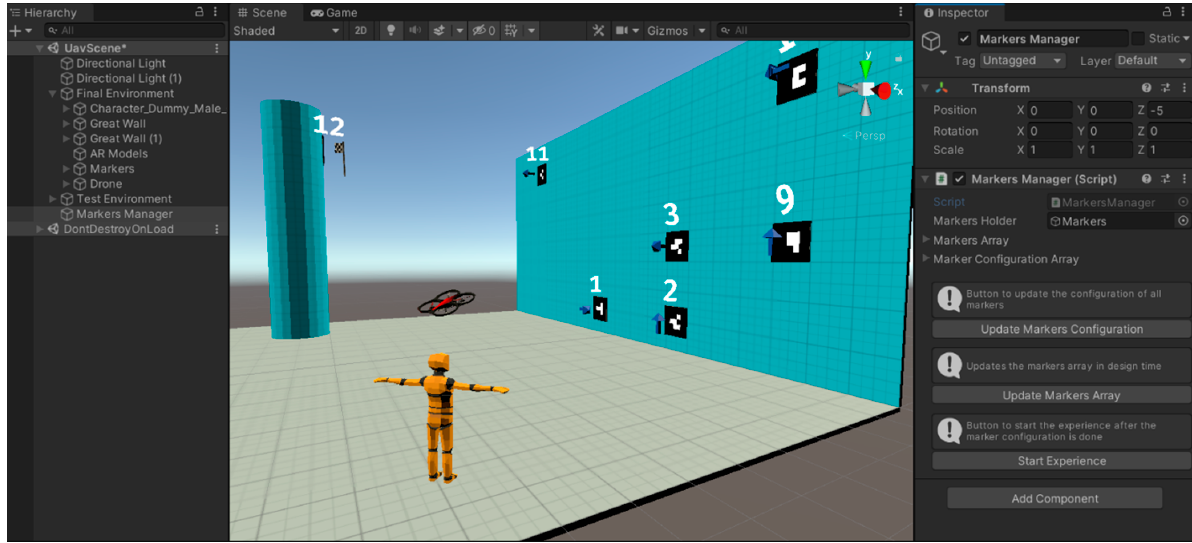
Figure 10. Screenshot of the early prototype developed with Unity.